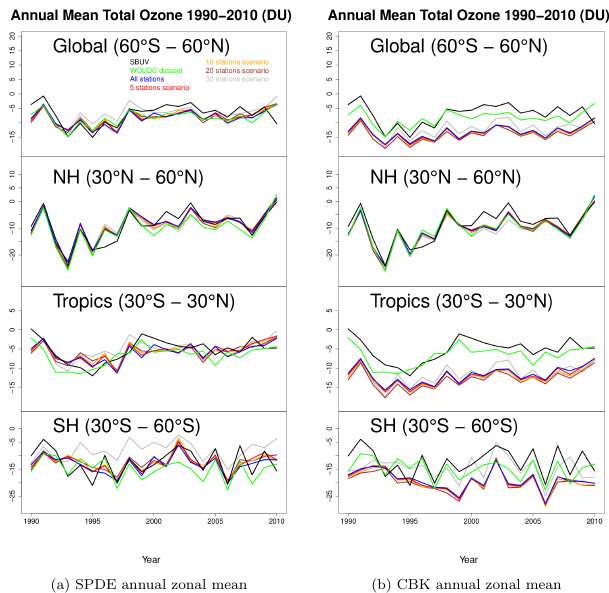
Figure 11. Annual zonal mean deviances from SBUV data (black), WOUDC data set (green), using all 57 available ground-based data (blue), random removed 5 (red), 10 (yellow), 20 (brown) and 30 (grey) stations in SPDE and covariance-based kriging (CBK) esti- mation over the (1) global (60 ◦ N–60 ◦ S), (2) NH (30–60 ◦ N), (3) tropics (30 ◦ N–30 ◦ S) and (4) SH (30–60 ◦ S) from 1990 to 2010. Table 7. Design of the sensitivity analysis: stations to be removed are randomly selected within each region. Number of removed